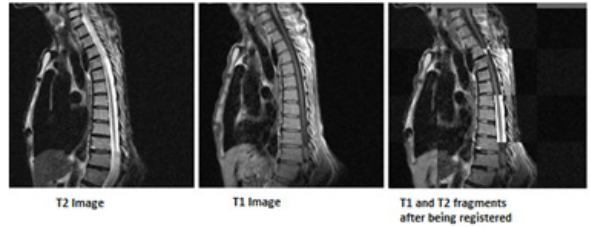
Figure 4. Registration of images. Source: Hospital Universitario Arnaldo Milián Castro, Cuba